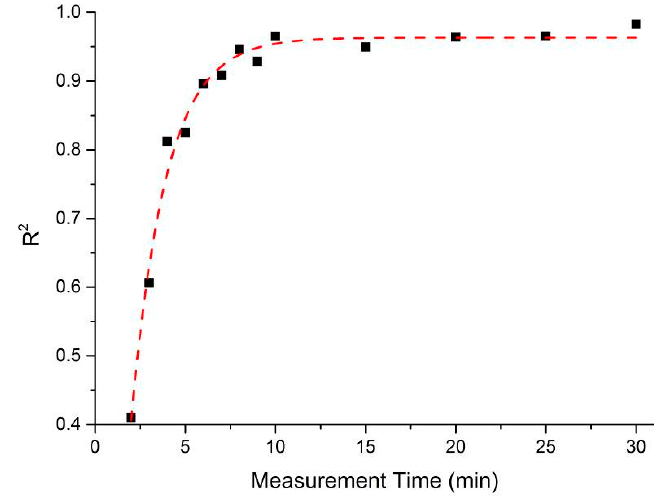
Figure 9. The relationship between R 2 value and measurement time of the sample inside the microwave cavity sensor.